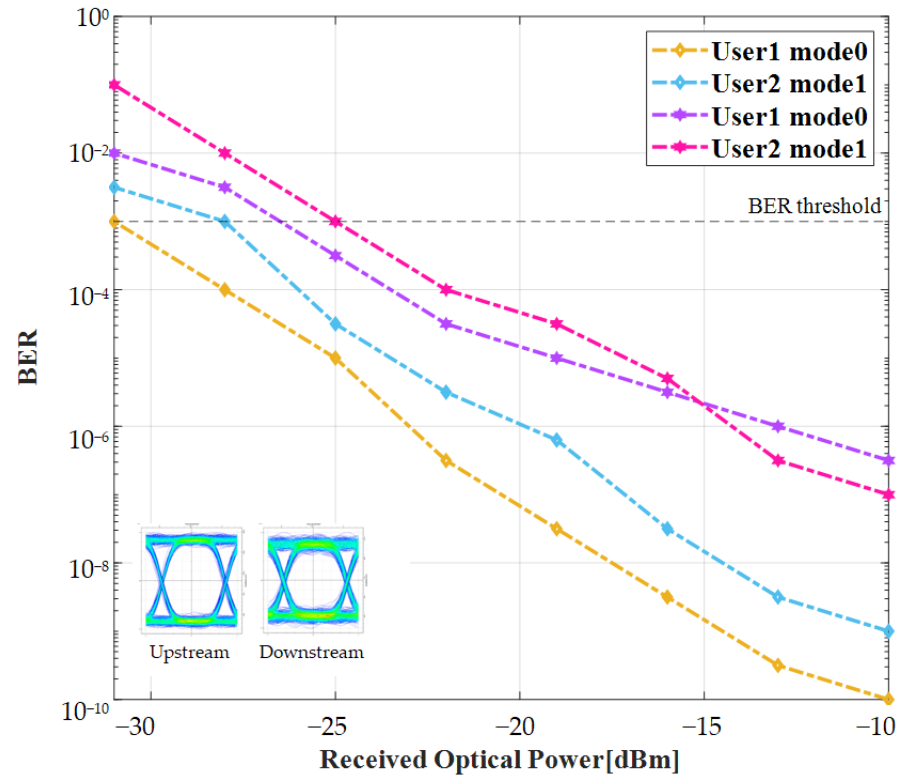
Figure 6. Measured BER vs. received optical power at 10/2.5 Gbit/s data rate over 1 km range for both User 1 and User 2 operating at modes 0 and 1 in downstream and upstream transmission. Insets: corresponding eye patterns over – 20 dBm received power for User 1 operating at mode 0.